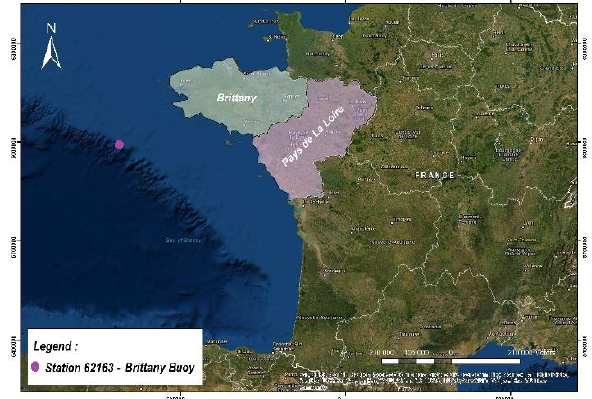
Figure 1 . Location of the study